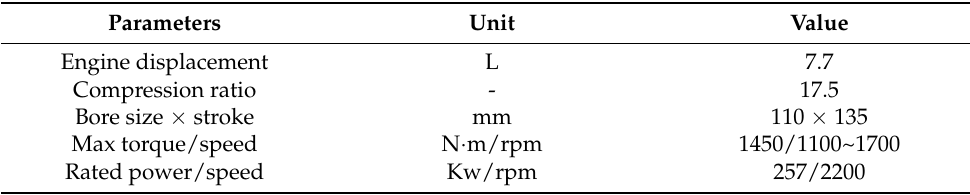
Table 2. Test engine